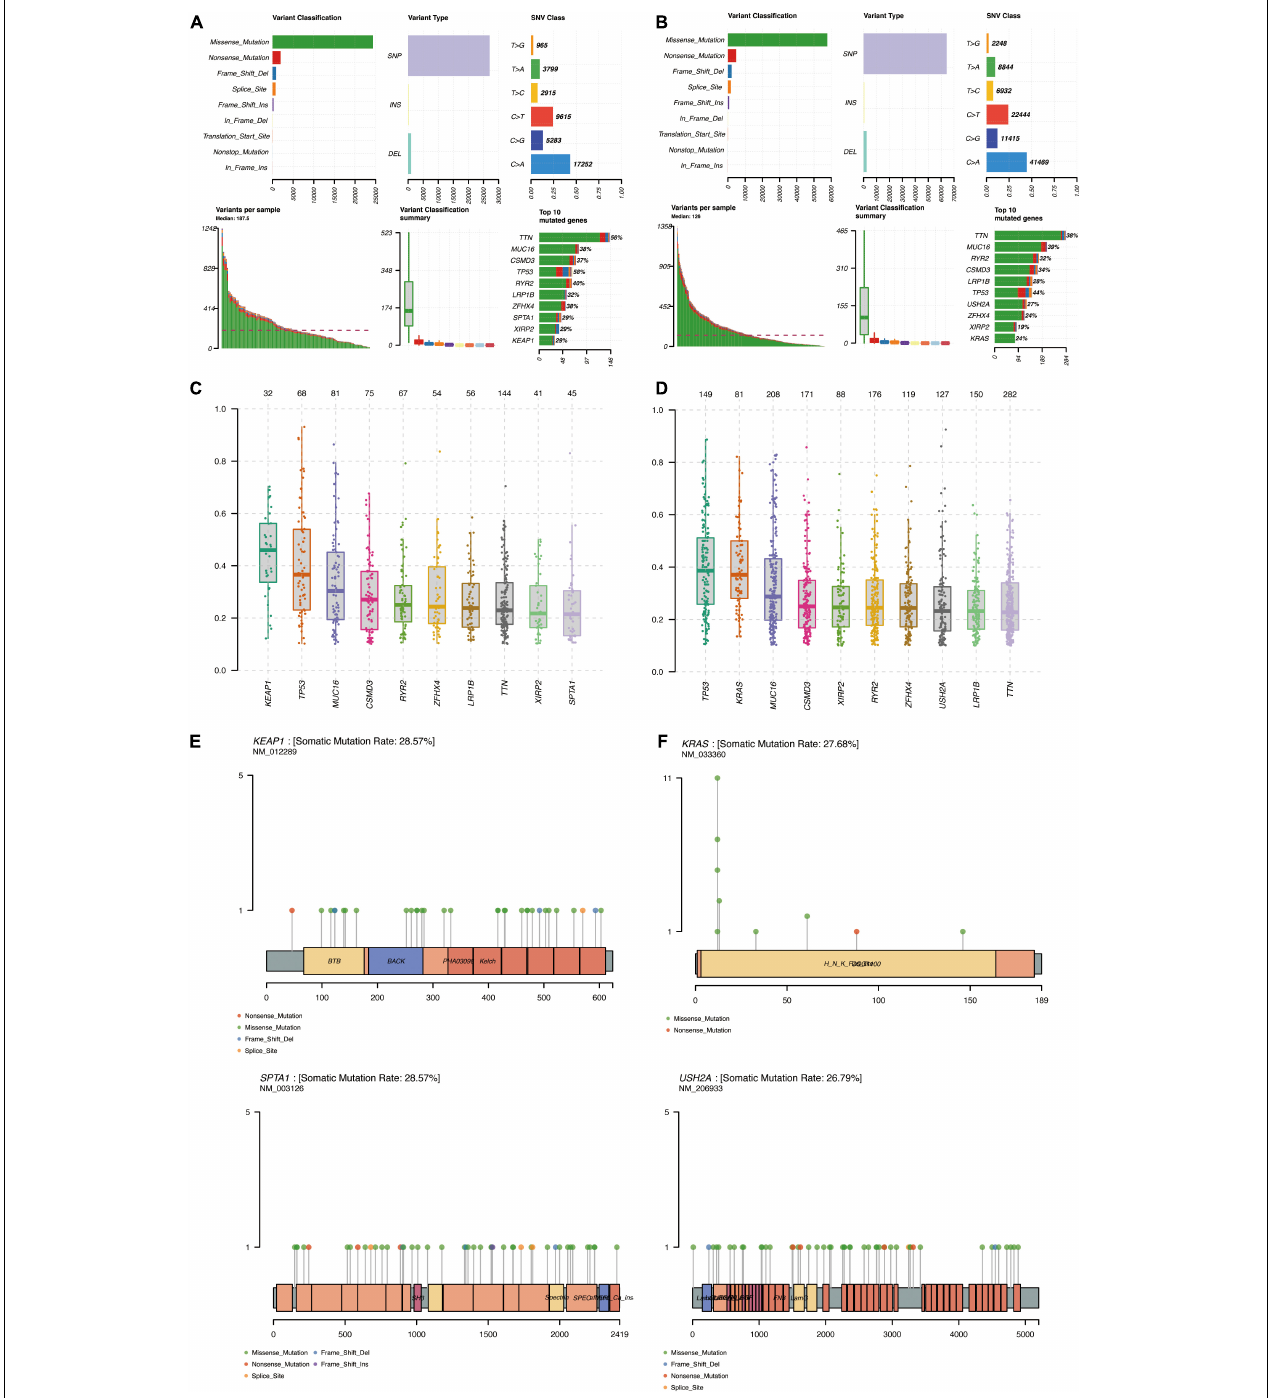
FIGURE 8 | Summary of mutation profiling of LUAD in the MAF file. (A,B) Statistical calculations of mutation types in cluster 1 and cluster 2. (C,D) VAF of LUAD in cluster 1 and cluster 2. (E,F) Lollipop plot of special mutated genes in cluster 1 and cluster 2. MAF, minor allele frequency; LUAD, lung adenocarcinoma; VAF, variant allele